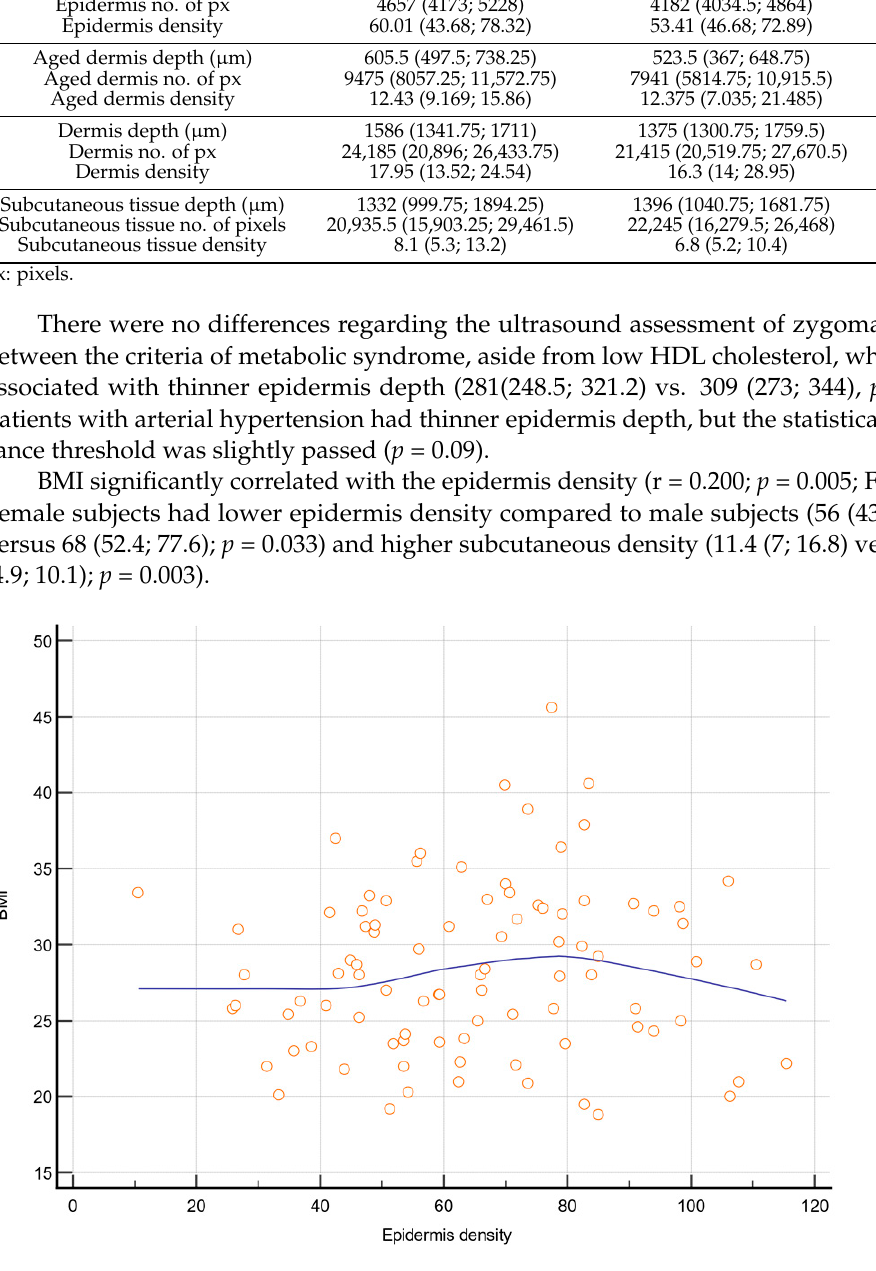
Figure 5. Correlation between BMI and epidermis density. BMI—Body Mass Index (kg/m 2 ). Females had thicker aged dermis (527 (412; 609) versus 719 (619.2; 1083.7); p < 0.001), lower aged dermis no. of pixels (8343 (6337.5; 9598.5) versus 11,845.5 (9444; 16,325); p < 0.001), lower entire dermis depth (1391 (1253; 1582) versus 1796 (1670; 2384.75); p < 0.001), Figure 6, and lower pixels count of the dermis (21,569 (19,894; 24,412.75) versus 28,047 (25,607; 37,343.75); p < 0.001).